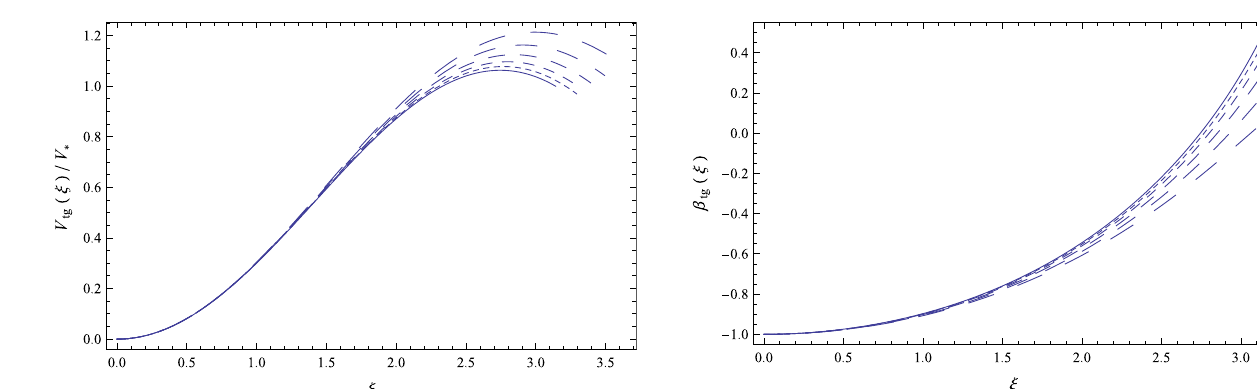
Fig. 4 Variation of the dimensionless tangential velocity of test parti- cles V tg (ξ)/ V ∗ , V ∗ = 4 πρ c / k 2 , as a function of ξ = kr , for a rotating Bose–Einstein condensate dark matter halo for different values of (cid:14) 2 : (cid:14) 2 = 0 (solid curve), (cid:14) 2 = 0 . 01 (dotted curve), (cid:14) 2 = 0 . 0225 (short dashed curve), (cid:14) 2 = 0 . 04 (dashed curve), (cid:14) 2 = 0 . 0625 (long dashed curve), and (cid:14) 2 = 0 . 09 (ultra-long dashed curve), respectively